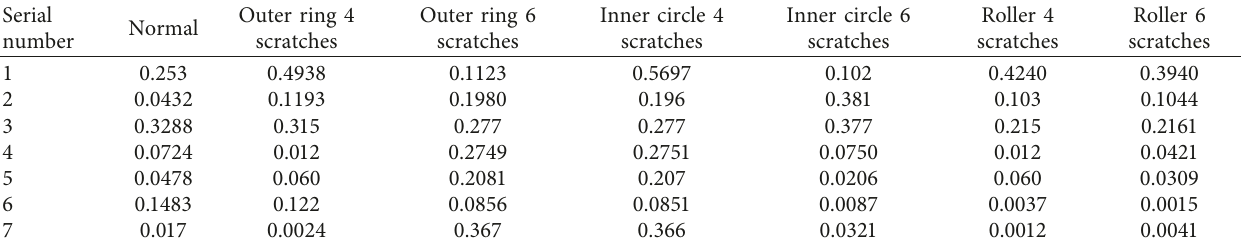
Table 3: Energy distribution of the first category example failure mode (inner ring, outer ring, and roller).